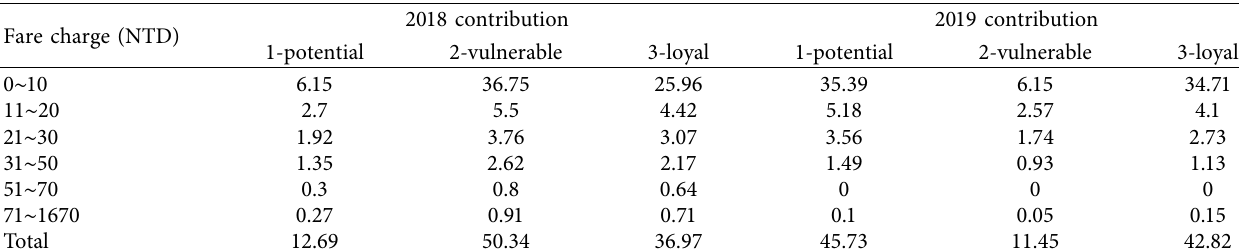
Table 19: % annual YouBike revenue generated among different customer groups in 2018 and